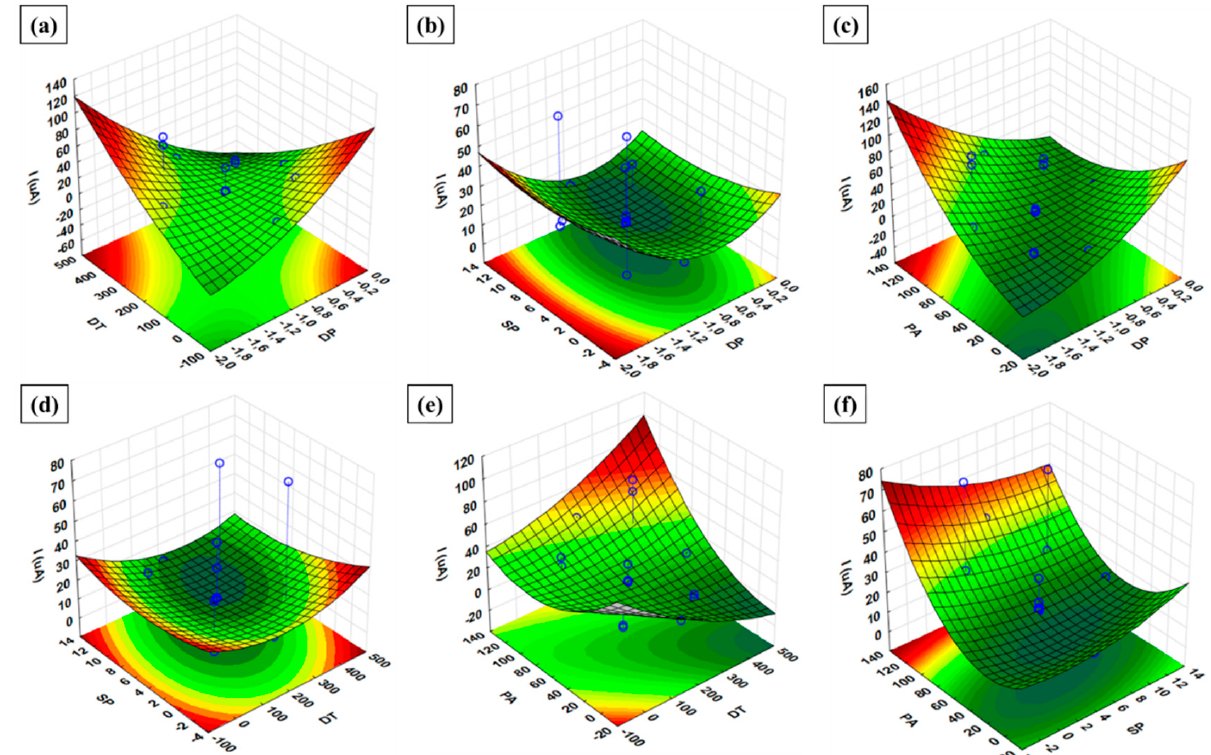
Figure 8. RSM plots for the optimization of Zn(II).